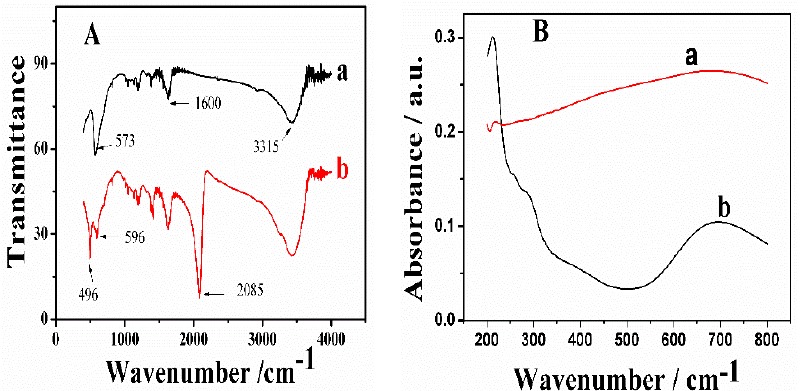
Figure 3. ( A ) FTIR spectra of pure Fe 3 O 4 nanoparticles ( curve a ) and magnetite PB nano-composites ( curve b ); ( B ) UV-vis absorption spectra of Fe 3 O 4 nanoparticles ( curve a ) and magnetite PB nano-composites ( curve b ).